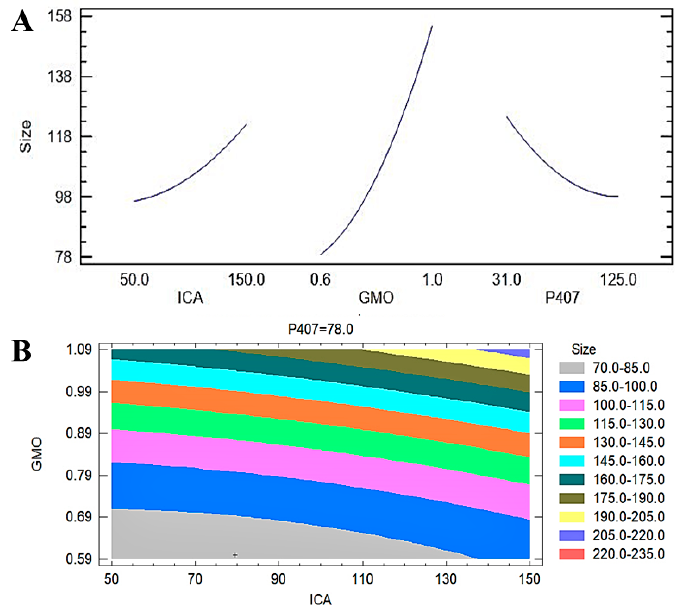
Figure 3. ( A ) Main plot effect of ICA, GMO, and P407 concentrations on the EE of ICA-Cubs. ( B ) Contour plot of the effect of ICA, GMO, and P407 concentrations on the particle size of ICA-Cubs.